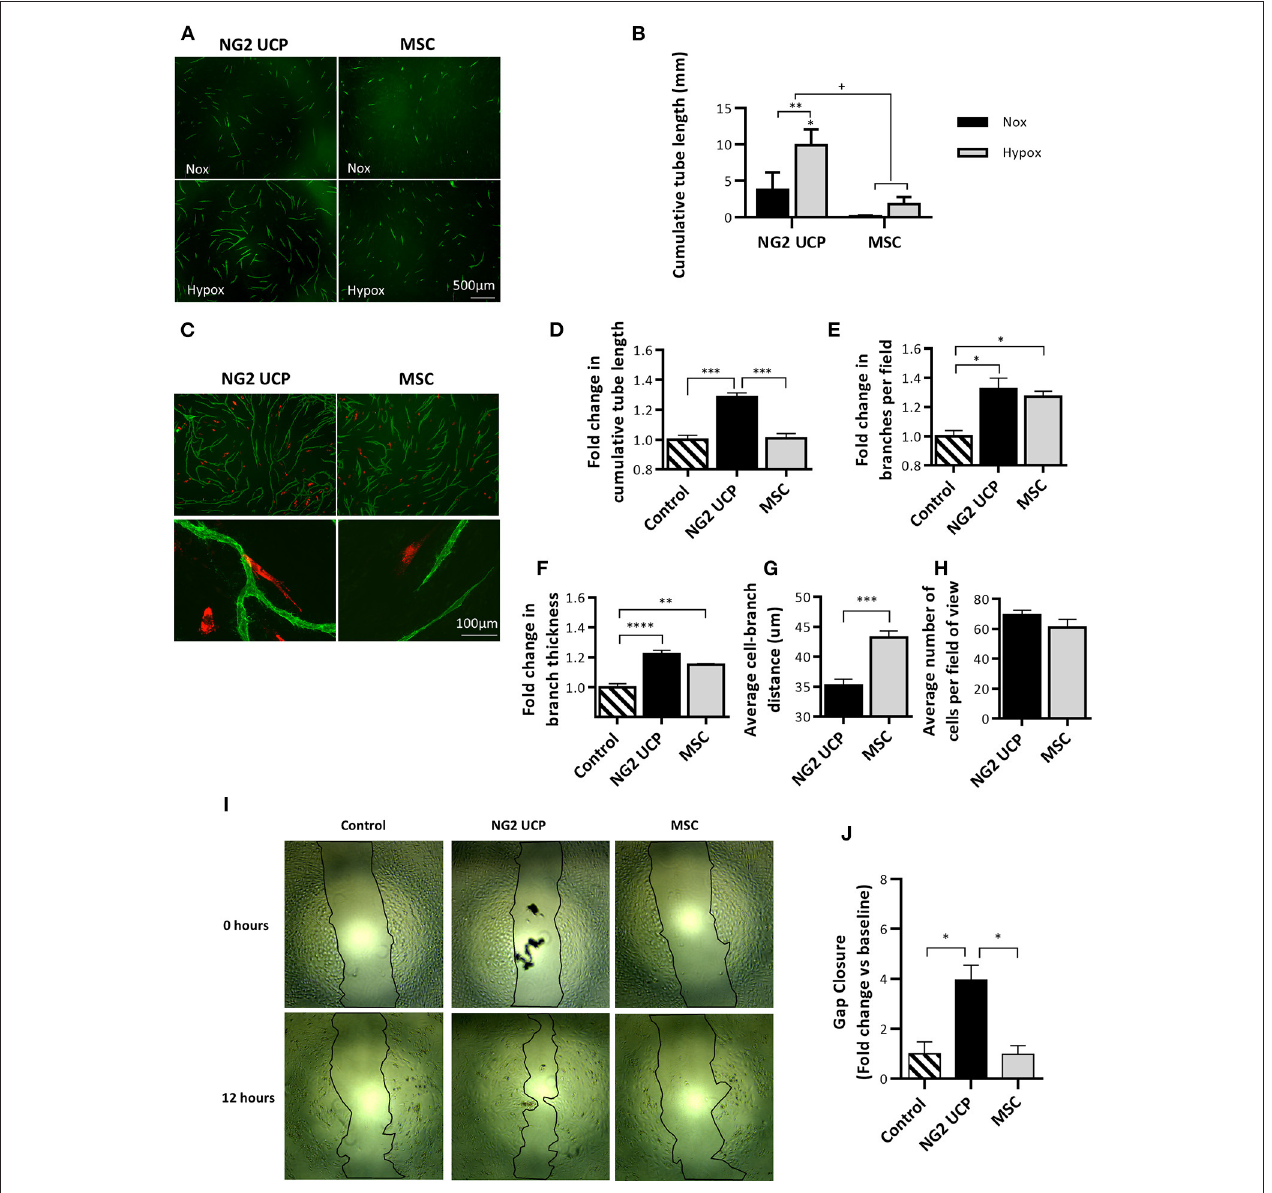
FIGURE 6 | Analysis of NG2 UCP angiogenic potential. (A) Representative images of endothelial tube network formation after incubation with normoxic or hypoxic CM. (B) Cumulative tube network using normoxic and hypoxic CM. Note that basal medium control resulted in no network formation. For clarity, control has been omitted, however, a significant increase from control is represented directly above NG2 UCP hypoxia column. Data represent means ( ± S.E.M). MSCs and NG2 UCPs, n = 3 and 6 biological replicates, respectively. * / + p < 0.05 and ** p < 0.01. *represents differences between hypoxia and normoxia, + represents differences between cell types. (C) Representative images of endothelial tube network formation with the inclusion of red labeled NG2 UCPs or MSCs in the endothelial cell-fibroblast co-culture. (D) Fold change in cumulative tube length vs. endothelial cell-fibroblast only control. (E) Fold change in branches per field vs. endothelial cell-fibroblast only control. (F) Fold change in branch thickness vs. endothelial cell-fibroblast only control. (G) Average distance of cell to branch. (H) Average number of cells per field of view. For (D–H) , data represent means ( ± S.E.M) MSCs and NG2 UCP, n = 4 and 6 biological replicates, respectively. * p < 0.05, ** p < 0.01, *** p < 0.001, and **** p < 0.0001. (I) Representative scratch-wound migration assay images at 0 and 12h. (J) Summary of fold change in migration vs. control. Data represent means ( ± S.E.M) n = 3 biological replicates. * p <